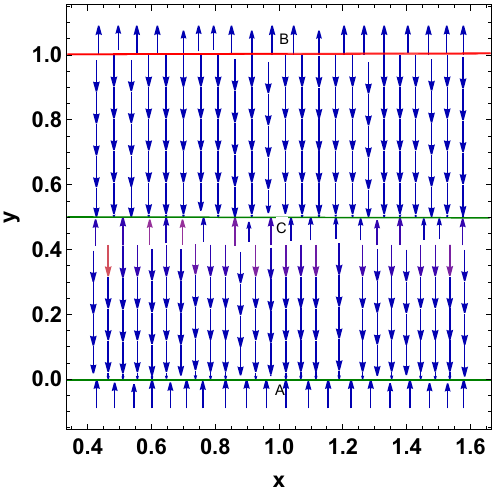
Fig. 3 Phase plots corresponding to the case β = 0 with κ = 1 and ¯ α = 1 with β (cid:2)= 0 successfully describes the observed transition from decelerated phase to an accelerated phase of the uni- verse and hence the considered non-linear model I behaves like standard (cid:4) CDM model. Moreover, our obtained results agrees with the cosmological implications of the same model found in [29]. Lastly, we found that the non-linear model II f ( Q , T ) = Q + α Q 2 + β T with α (cid:2)= 0 represents an accel- erated de-Sitter epoch for the constraint β < − 1 or β ≥ 0.